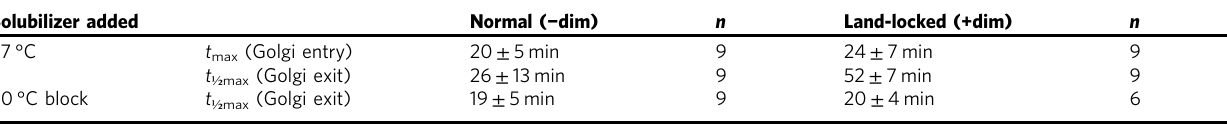
Table 2 Summary quanti fi cation of a wave of cargo through individual normal or land-locked Golgi areas in living cells Solubilizer